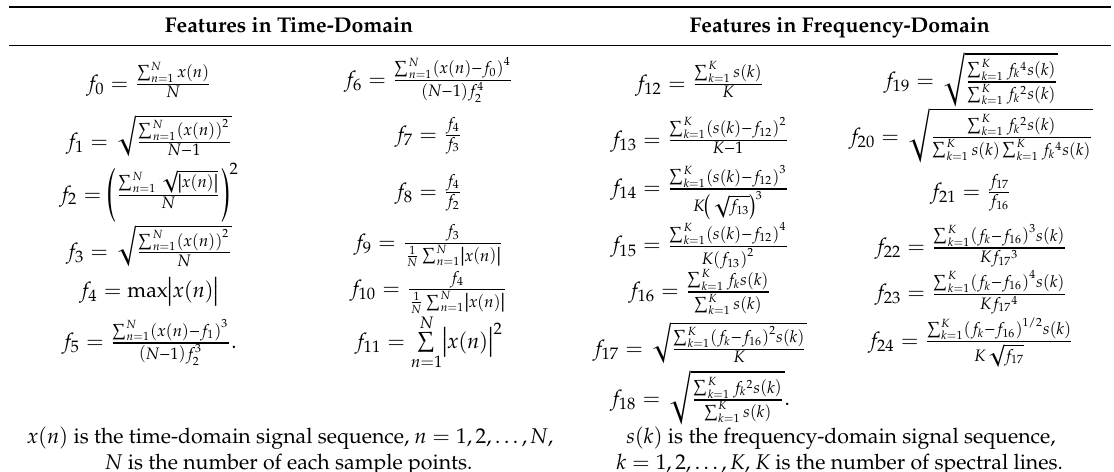
Table 3. Global features in the time-domain and frequency-domain [30,31].